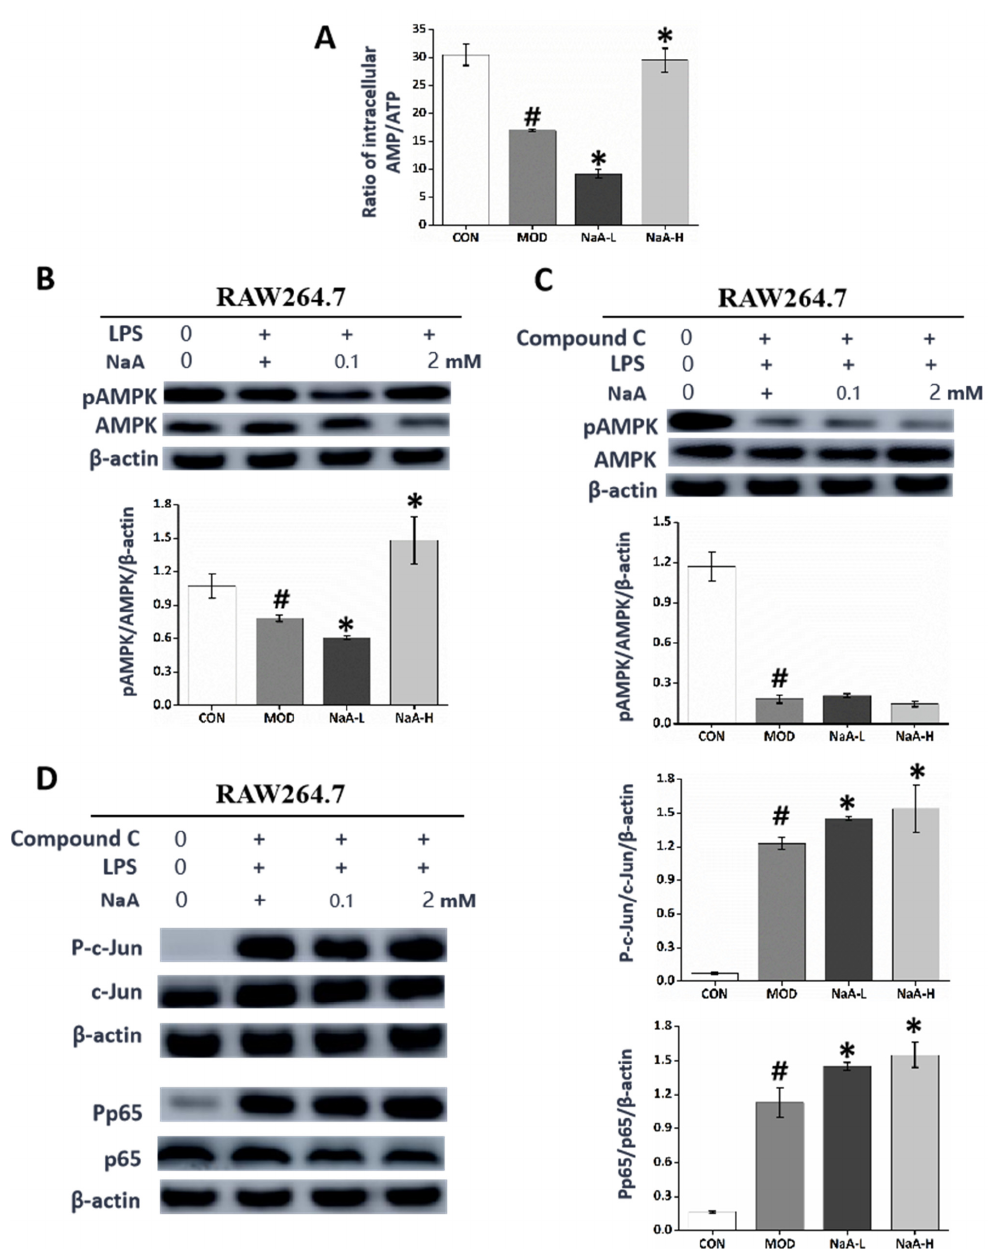
Figure 5. NaA-regulated macrophage inflammatory response is related to AMPK activity. ( A ) HPLC was used to evaluate the intracellular AMP/ATP ratio. ( B ) Western blot was used to evaluate the phosphorylation of AMPK. ( C ) Inhibitory effect of Compound C on AMPK. ( D ) Western blot was used to evaluate the phosphorylation of c-Jun and p65 treated by Compound C. For all bar graphs, data are the mean ± SD, # p < 0.05, as compared with CON, and * p < 0.05, as compared with MOD. The significant difference was assessed using the one-way ANOVA followed by LSD